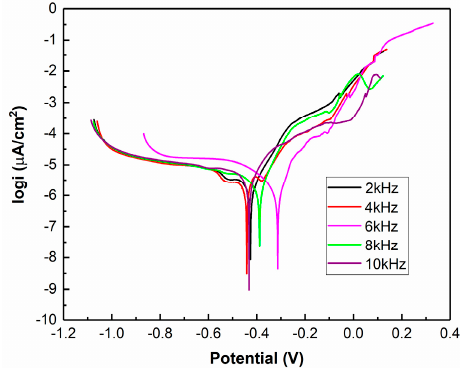
Figure 11. Polarization curves of Ni–Co–BN (h) nanocomposite coatings with varying pulse frequencies. Table 3. Electrochemical parameters of different samples. Pulse Parameters